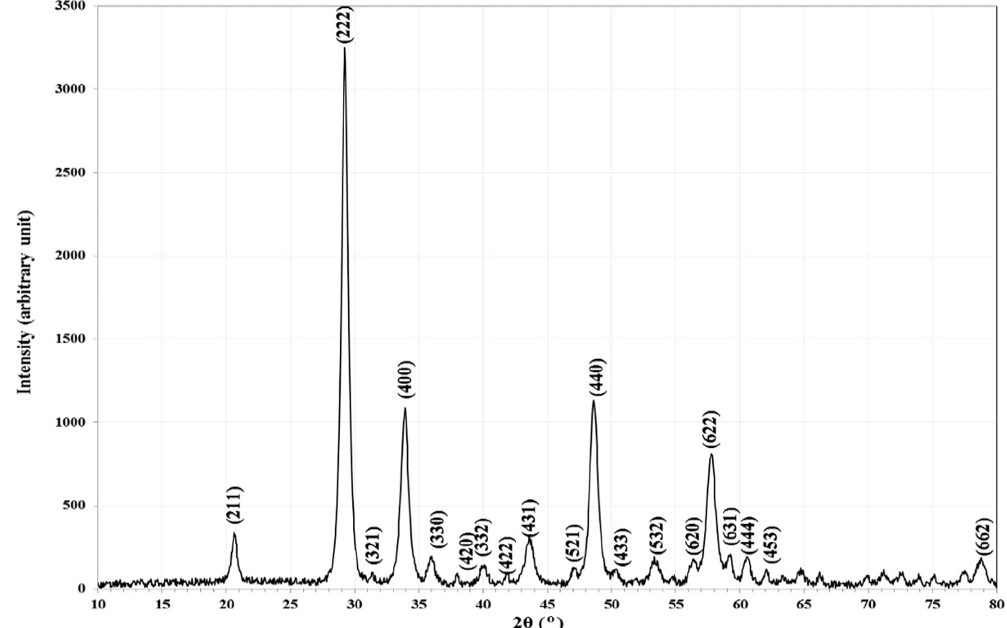
Figure 11. XRD of Er 2 O 3